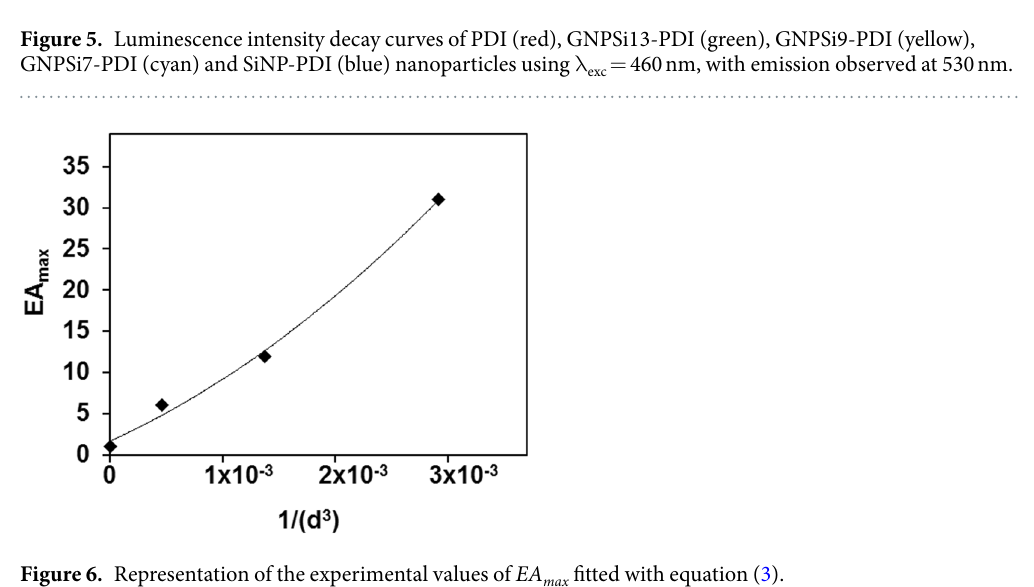
Figure 6. Representation of the experimental values of EA max fitted with equation